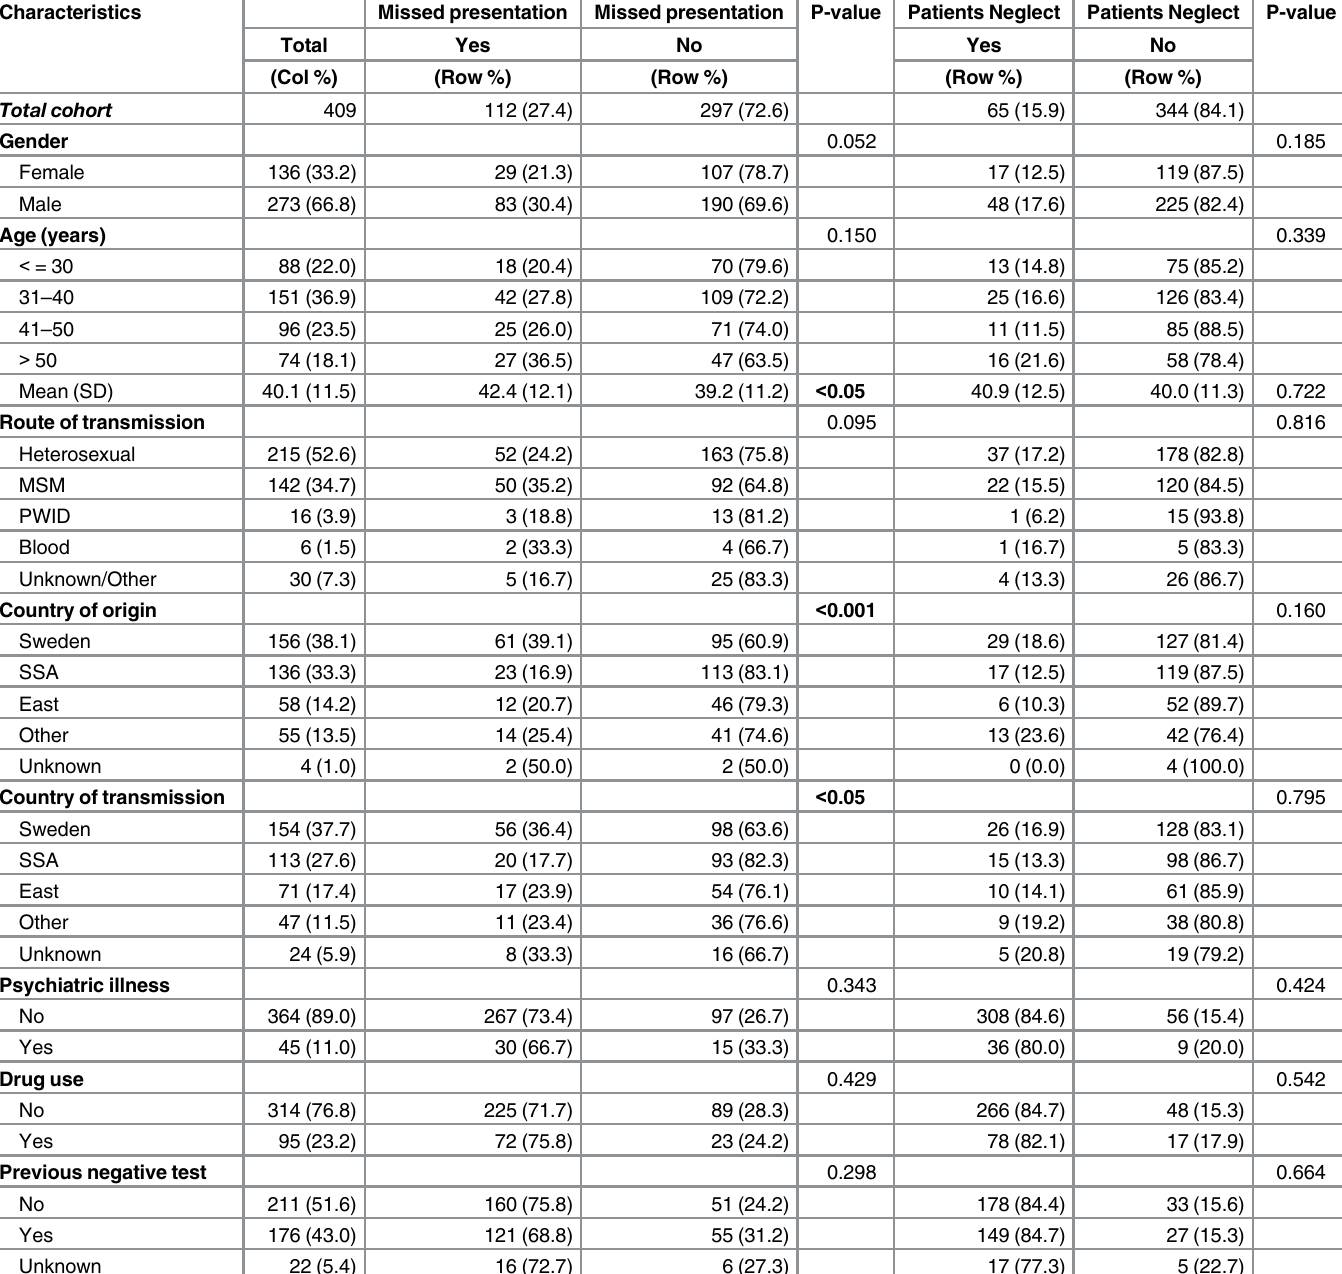
Table 1. Descriptive and bivariate analysis of explanatory variables for “ Missed presentation ” and “ Patients neglect ” three years preceding HIV-1 diagnosis in 409 newly diagnosed patients. MSM, men who have sex with men; PWID, people with injecting drug use; SSA, sub-Saharan Africa; ‘ East ’ , Eastern Europe, Asia and the Pacific region; ‘ Other ’ , Western Europe, North and Latin America, the Caribbean, North Africa, Israel and the Middle East.